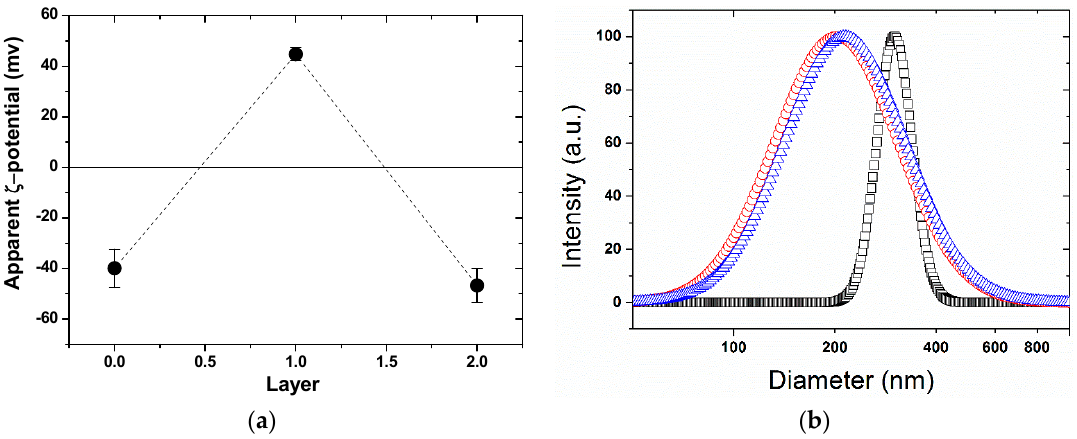
Figure 4. ( a ) Zeta-potential of multilayer SPBs as a function of the number of deposition layers; ( b ) DLS curves of multilayer modified SPBs. Symbol denotes: ( □ , black) SPBs; ( ○ , red) PAA-PAH double-layers; ( ∆ , blue) PAA-PAH-PAsp triple-layers. (pH = 7, C NaCl = 10 mM).